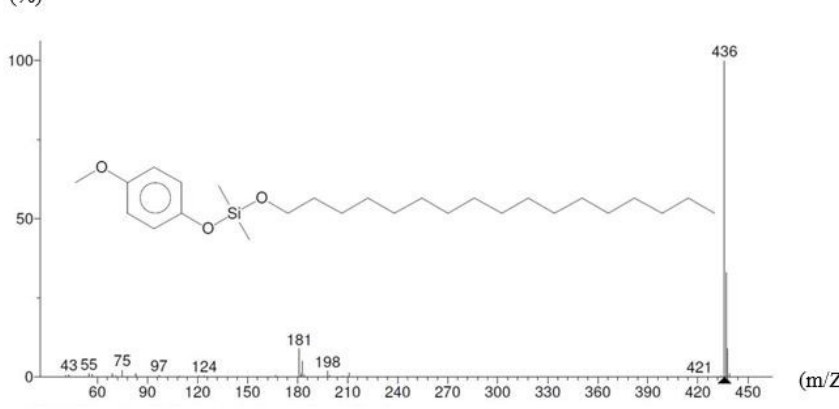
Figure 5. Silane and its molecular mass detected using a Gas Chromatography and Mass Spectrometry (GC-MS) test.